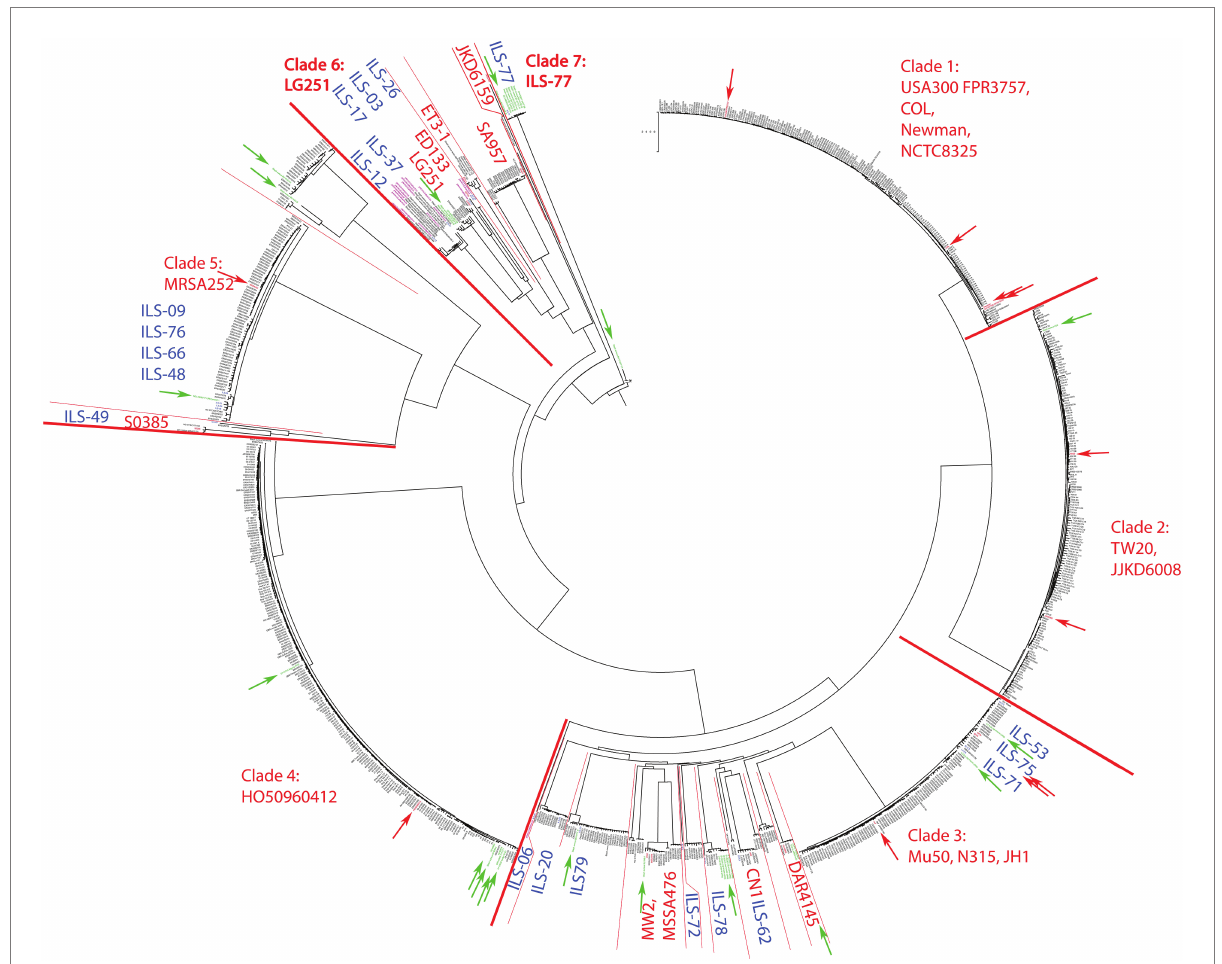
FIGURE 1 cgMLST tree of 956 S. aureus strains calculated on pathogen.watch using various reference S. aureus strains highlighted in each clade. For better visualization of the main phylogenetic tree structure, the branch length connecting the base of the tree ( S. aureus BU G1201 t13 as the most distant strain) was cut from 854 ′ 621 units to 200 units and indicated accordingly. Blue indicates ILS strains reported in this study. Red boundaries and arrows indicate clade boundaries and tree location of all main reference strains, respectively. Green arrows indicate strains of African origin not originating from this